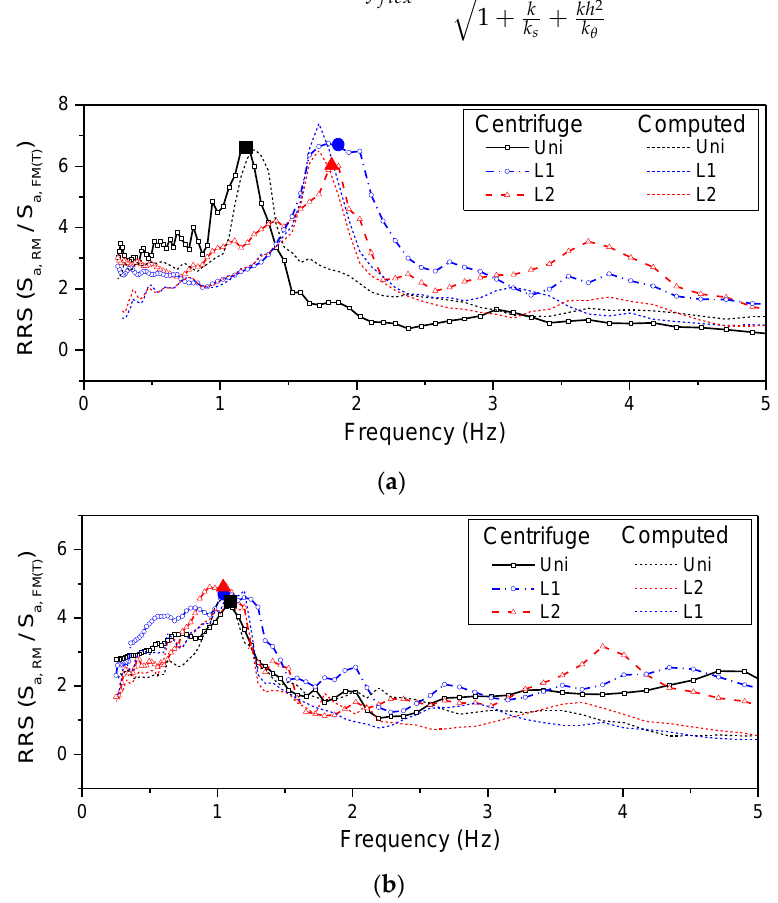
Figure 6. Ratio of response spectra (RRS) of roof motion (RM) to foundation motion (FMT) for three soil profiles at ( a ) PGA = 0.1 g and ( b ) PGA = 0.22 g . Solid markers indicate peak RRS corresponding to f flex for each case.